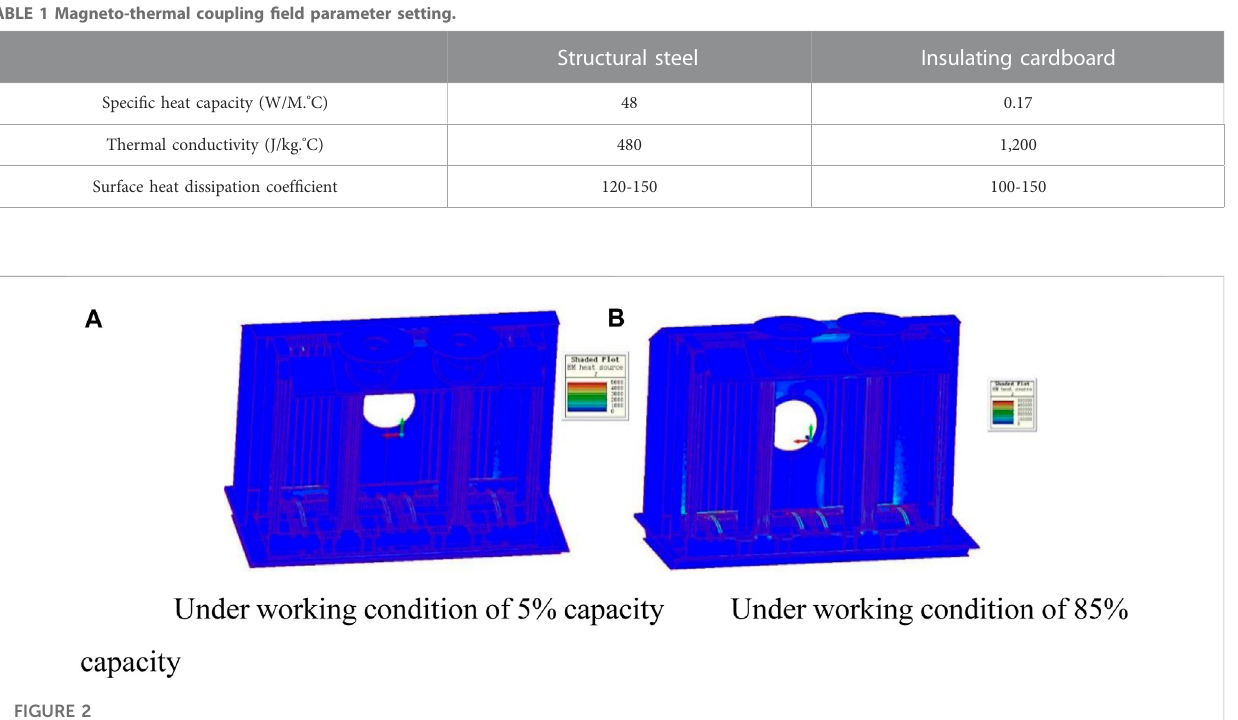
FIGURE 2 Cloudmapofelectromagneticheatsourcedensitydistributionoftransformerstructureunderworkingconditionof (A) 5%capacity (B)